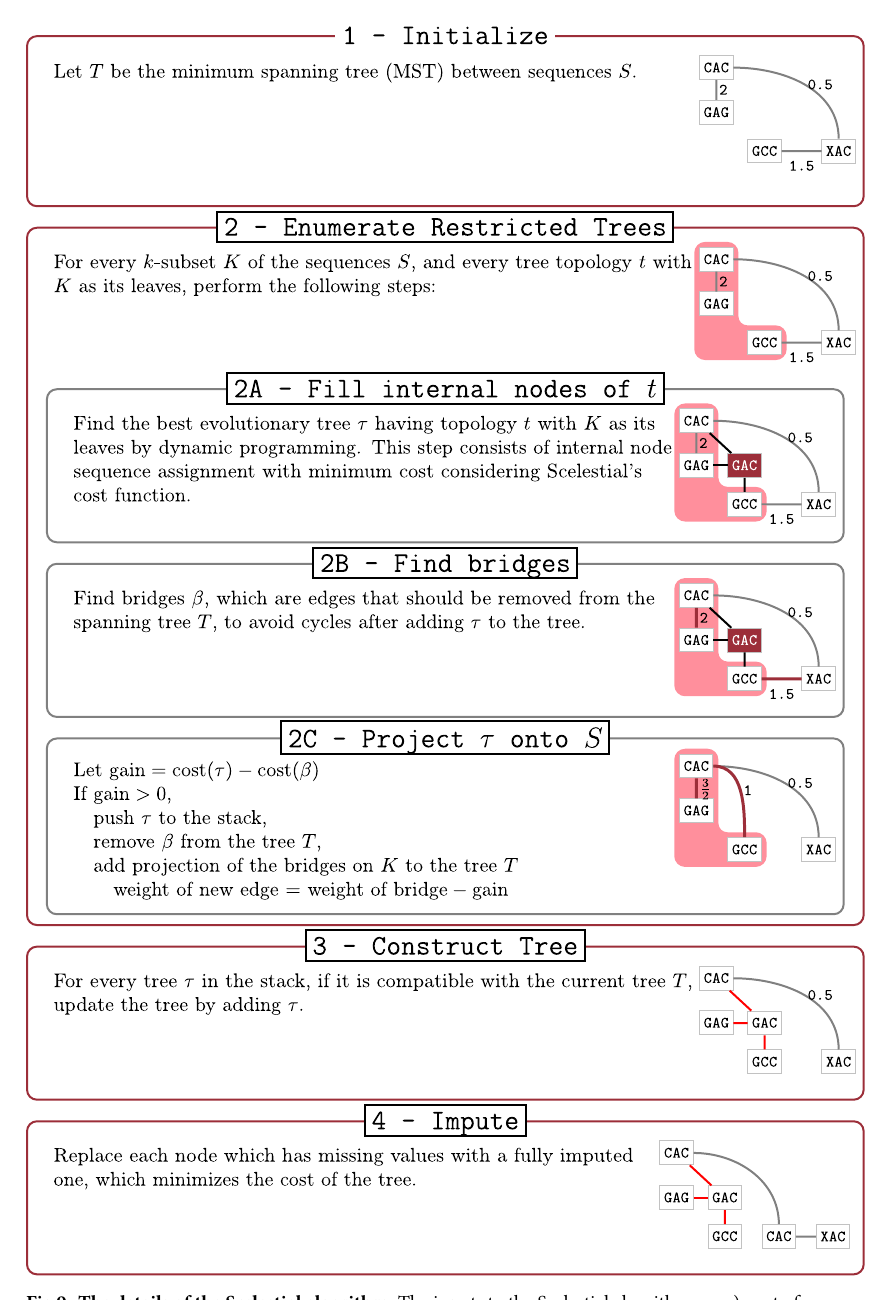
Fig 9. The details of the Scelestial algorithm. The inputs to the Scelestial algorithm are a) a set of sequences S , b) the degree of restriction of the restricted Steiner tree k . The value k represents the size of trees to be considered as potential improvement for the tree T (details in Section 3.5.1). An example is shown at the right side of each step. The input sequences S are “CAC”, “GAG”, “GCC”, and “XAC” (“X” represents a missing value). In step 1 the tree T is initialized with the minimum spanning tree of the input sequences S . The edge lengths represent the cost of the edge according to the Scelestial’s cost function (see Section 3.5.5). In step 2 an example of a subset of sequences for K is highlighted in the picture. In step 2A a tree τ over leaf nodes K is shown. In step 2B bridges are highlighted as red edges between input sequences. In step 2C the result of adding tree τ to the current tree T is shown. In this example the bridges shown in step 2B are removed and two edges between nodes K corresponding to bridges are added. For each bridge an edge between the two nodes from K which their path passed through the edge is added. The new costs are defined as it is shown in step 2C. In step 3, the trees τ are added to the tree with their corresponding internal nodes. In step 4 lowest cost imputation of sample nodes are added to the tree, in the sample place as input sequences.